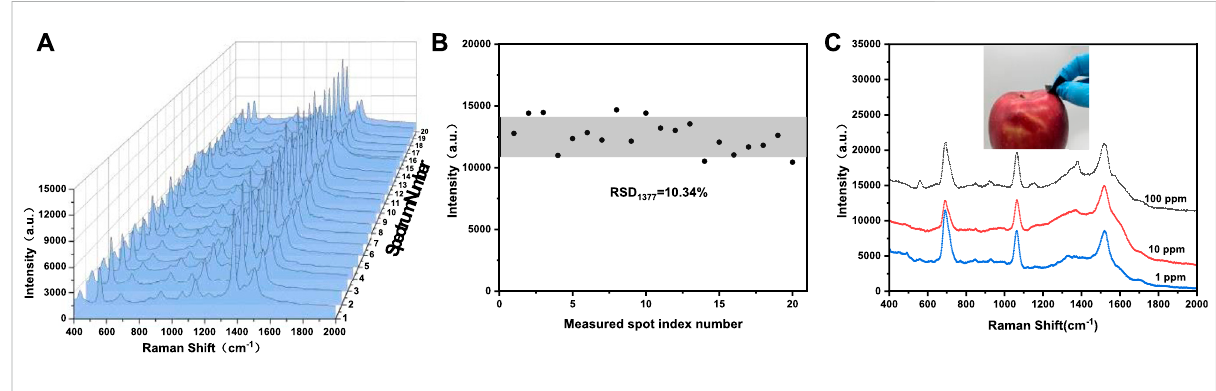
FIGURE 8 (A) Ramanspectraof200 ppmthiramcollectedfrom20randomlyselectedspotsfromthesameAu-Ag 8 -3-FPsubstrate, (B) thescatterdiagram of intensity distribution of the 1377 cm − 1 peak of thiram corresponding to spectra in (A) , (C) Raman spectra of thiram with different concentration swabbed from the apple surface.